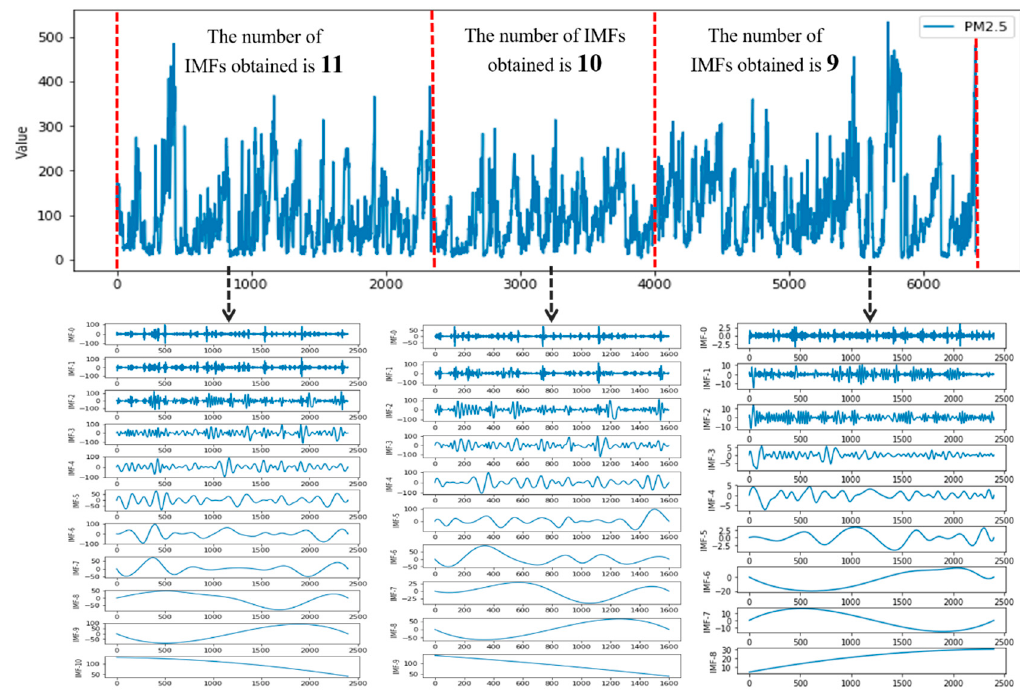
Figure 3. The number of IMFs within different time intervals of PM2.5.